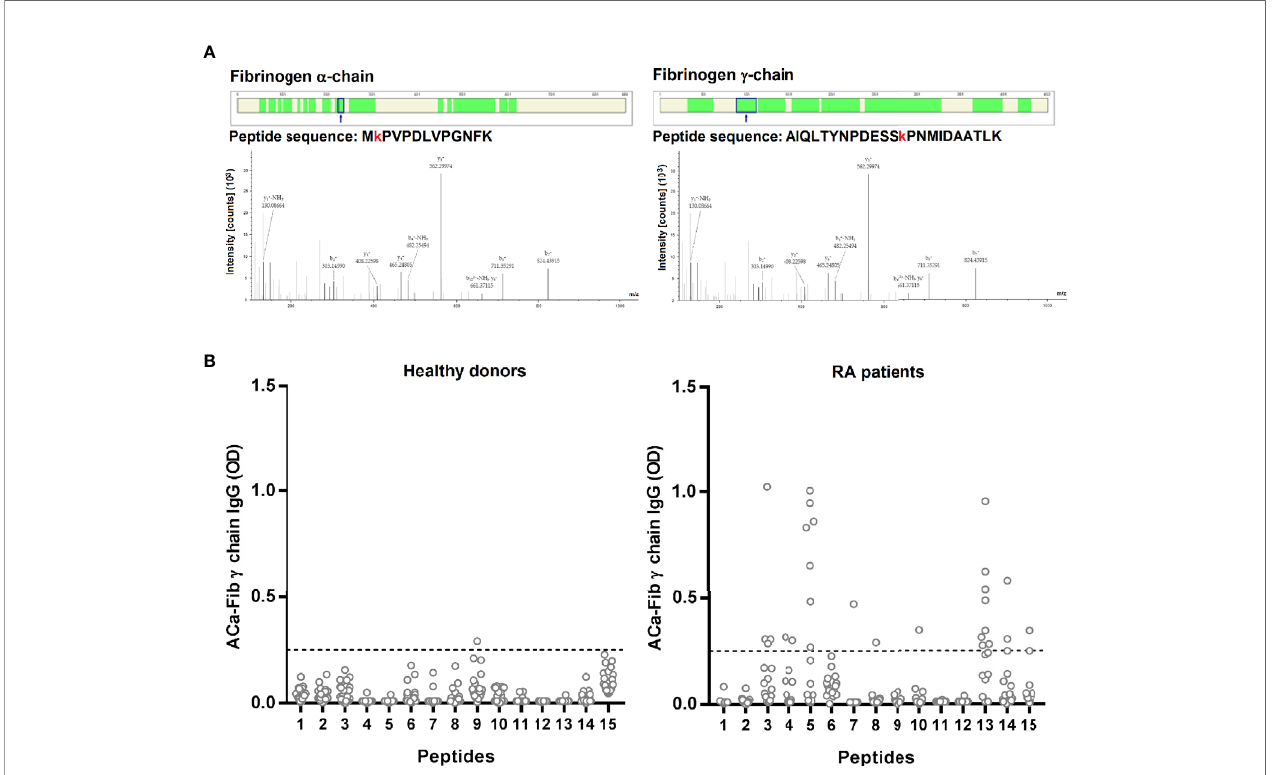
FIGURE 2 | Identi fi cation by MS/MS of carbamylated target of anti-CarP in situ and epitope mapping of the antibody response directed against the g chain of carbamylated fi brinogen. (A) Identi fi ed peptides on the a chain (40% of coverage rate) and g chain (65% of coverage rate) have a carbamyl residue on lysine. Filters used for identi fi cation are as follows: high peptide con fi dence; peptide rank 1 and a peptide score > 20. (B) ELISA test for detection of ACa-Fib g chain IgG from RA patients with Aca-Fib IgG (n=16) and healthy donors (n=30), expressed as OD (Optical Density) at 450 nm. ACa-Fib g chain, anti-carbamylated fi brinogen g chain antibodies. The horizontal line corresponds to the threshold of positivity (OD ≥ 0.25) and each point represents a